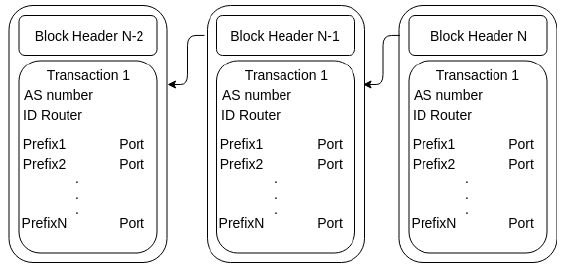
Figure 4. Data structure for